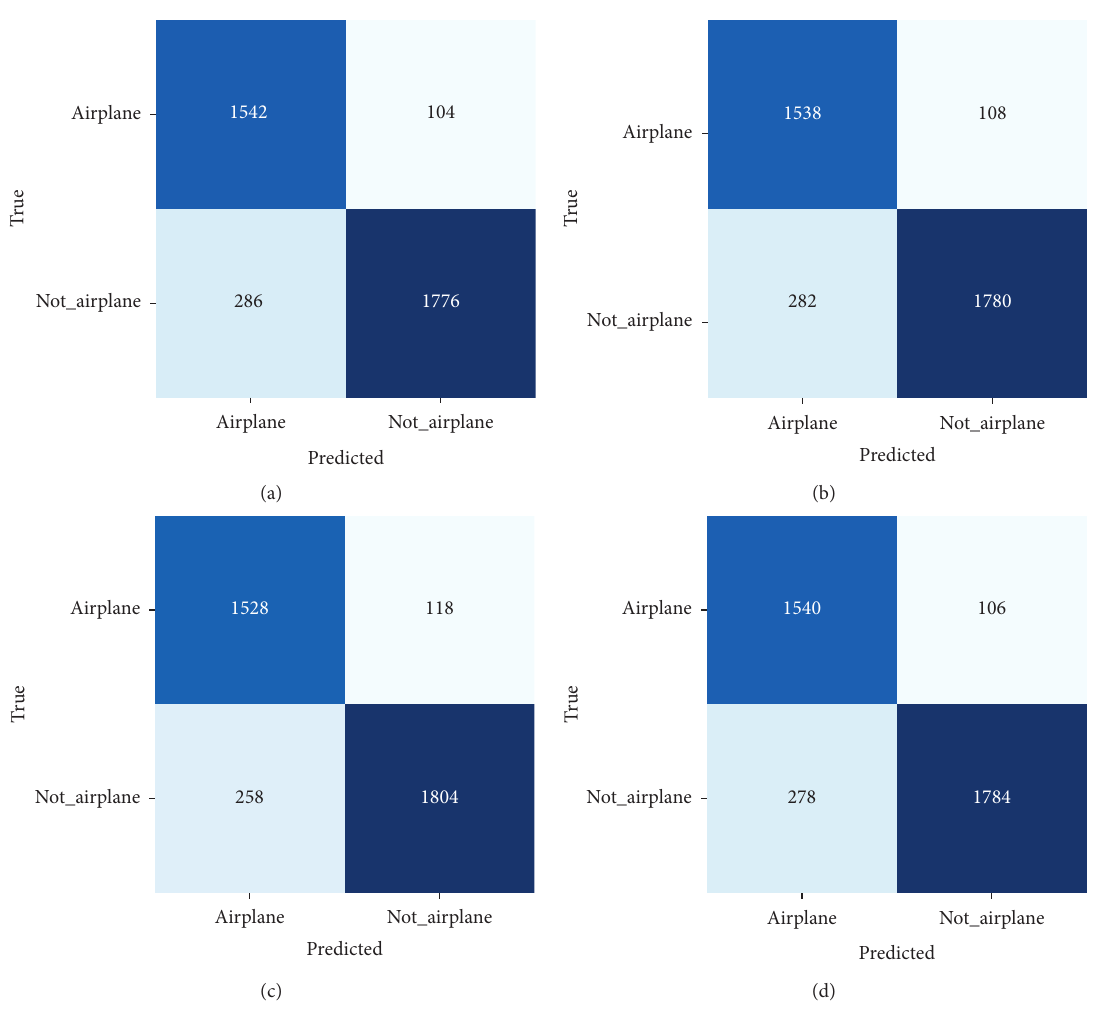
Figure 6: Confusion matrix: (a) the applied method (50, 50); (b) the applied method (150, 100); (c) the applied method (180, 300); (d) the gradient descent method. Table 2: Results of the applied method and the gradient descent optimizer for speech